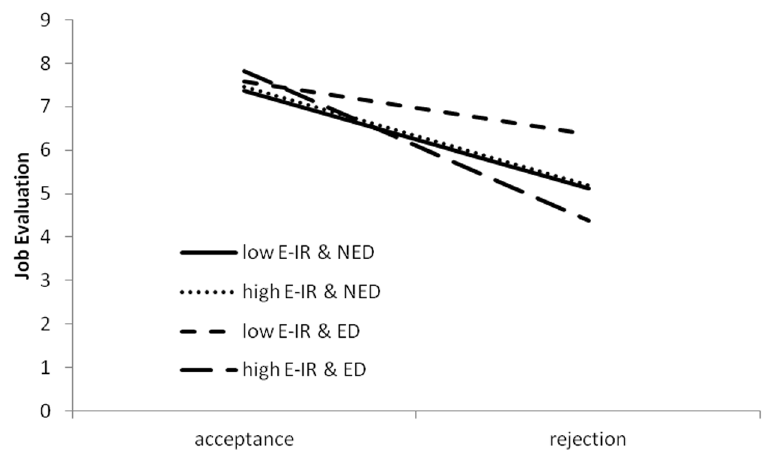
Figure 2. Interaction effect of rejection, Ego-Depletion (ED; NED, No Ego-Depletion) and E-IR on aggression. Slopes are plotted at the ±1 SD.